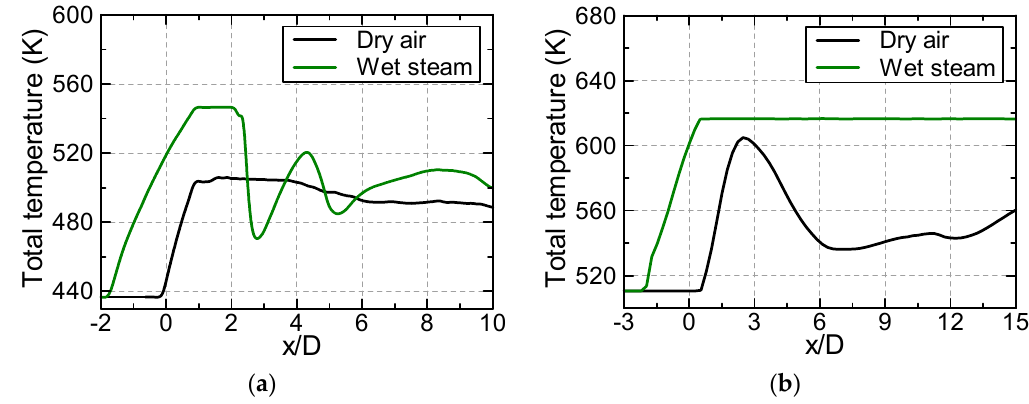
Figure 8. Distributions of total temperature along measuring line. ( a ) p 0 = 7 bar, T 0 = 436 K; and ( b ) p 0 = 32 bar, T 0 = 510 K.